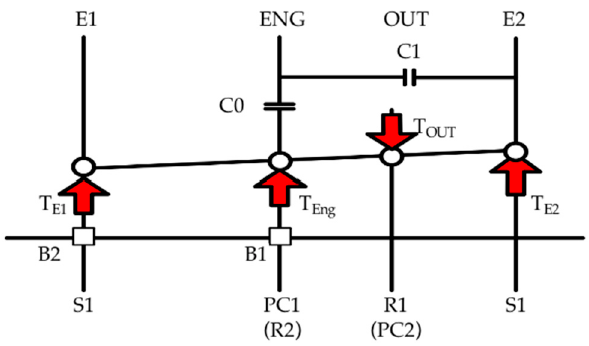
Figure 2. The equivalent levers diagram of the compound power-split system. Table 1. The working modes of the compound power-split system.